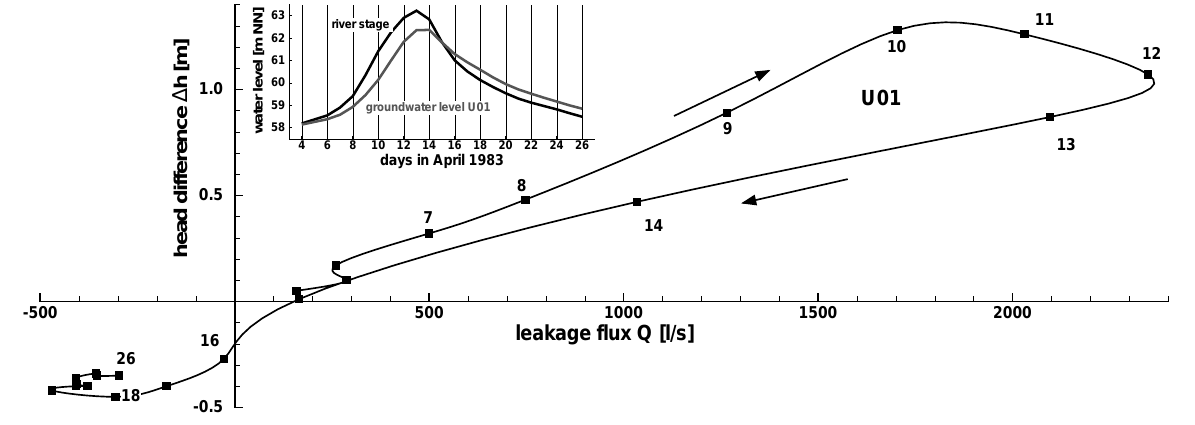
Figure 8. Head difference ∆ h over leakage flux Q for groundwater observation point U01. The points are connected according to the time line of the flood event. Numbers at the data points indicate the days in April,